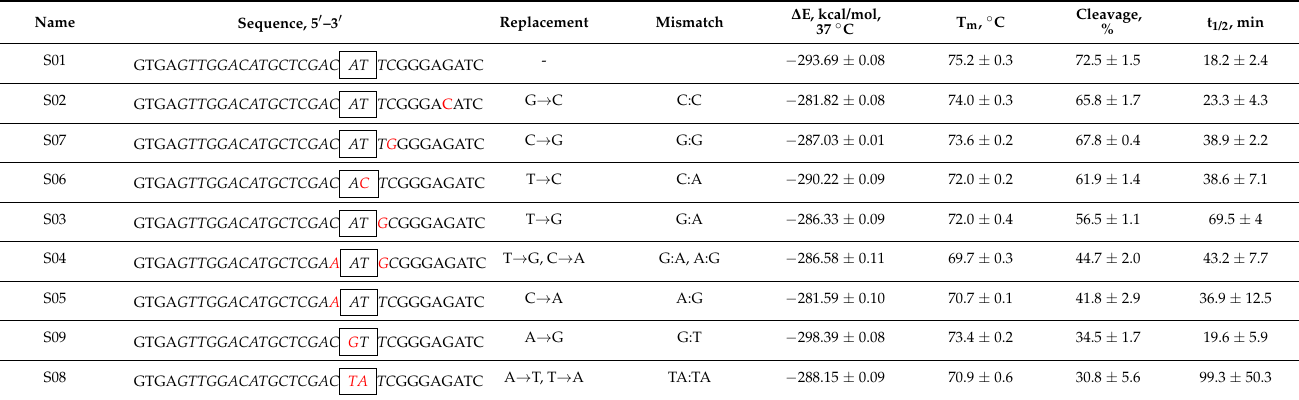
Table 1. The thermodynamic parameters of duplexes’ formation and the efficiency of their